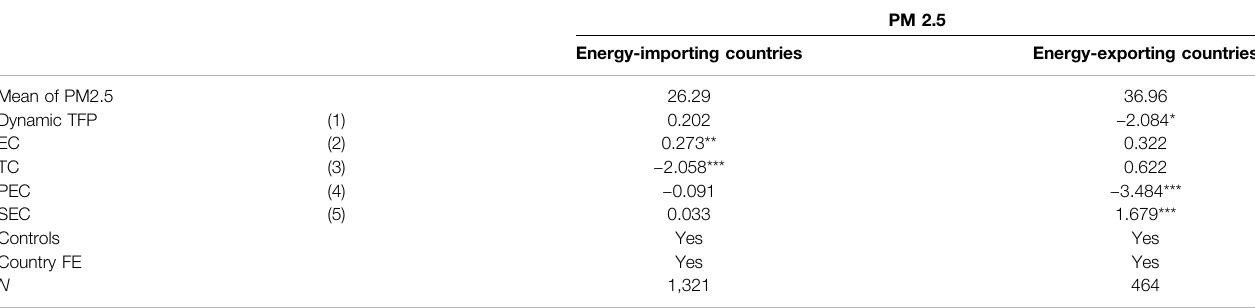
TABLE 11 | The estimation results for energy trade heterogeneity.